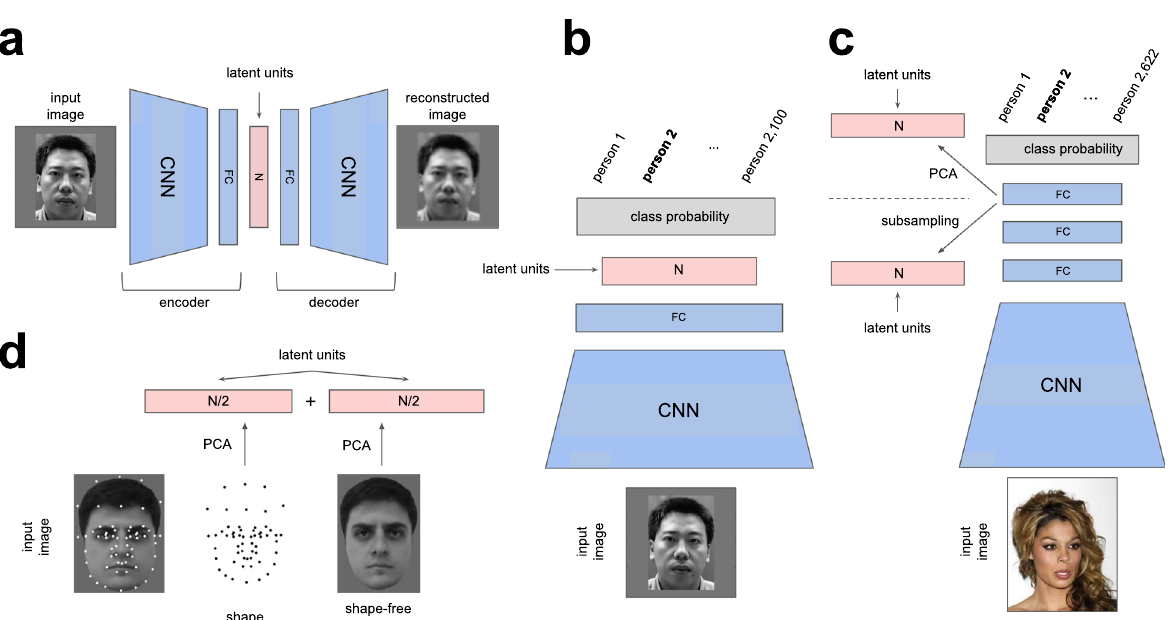
Fig. 8 Schematic of model architectures. Blue, trainable neural network units free to represent anything. Pink, latent representation units used for comparison with neurons in response to 2100 face images. Grey, units representing class probabilities. CNN, convolutional neural network. FC, fully connected neural network. N , number of latent units. a Self-supervised models — β -VAE 17 , autoencoder (AE) 35 and variational autoencoder (VAE) 36, 58 . Models were trained on the mirror fl ipped versions of the 2100 faces presented to the primates. Face image reproduced with permission from Gao et al. 57 . b Classi fi er baseline. Encoder network, same as in ( a ). Model trained to differentiate between unique 2100 face identities using mirror fl ipped versions of the 2100 faces augmented with 5 × 5 pixel translations. Face image reproduced with permission from Gao et al. 57 . c VGG baseline 32 . Encoder network has larger and deeper CNN and FC modules than in ( a ) and ( b ). Representation dimensionality is reduced to match other models either by a projection on the fi rst N principal components (PCs) (VGG (PCA)), or by taking a random subset of N units without replacement (VGG (raw)). VGG was trained to differentiate between 2622 unique faces using a face dataset 32 unrelated to the 2100 faces presented to the primates. Face image is representative of the images used to train the model and is reproduced with permission from Liu et al. 52 . d Active appearance model (AAM) 3 . Keypoints were manually placed on the 2100 face images. First N /2 PCs over the keypoint locations formed the “ shape ” latent units. First N /2 PCs over the shape-normalised images formed the “ appearance ” latent units. Figure adapted with permission from Chang et al. 3 applying principal component analysis (PCA) to the 2100 faces using sklearn 0.2 PCA package. To rule out the role of simply fi nding the independent components of the data during β -VAE training, we compared β -VAE to the N independent components discovered by independent component analysis (ICA) applied to the 2100 face images using sklearn 0.2 FastICA package. Finally, we also compared β -VAE to the active appearance model (AAM). Linear combinations of small numbers of its latent units (six on average) was previously reported to explain the responses of single neurons in the primate AM area well 3,6 . We re-used the AAM latent units from 6 . These were obtained by setting 80 landmarks on each of the 2100 facial images presented to the primates. The positions of landmarks were normalised to calculate the average shape template. Each face was warped to the average shape using spline interpolation. The warped image was normalised and reshaped to a 1-d vector. PCA was carried out on landmark positions and shape-free intensity independently. The fi rst N / 2 shape PCs and the fi rst N /2 appearance PCs were concatenated to produce the N - dimensional AAM representations (Fig. 8d).